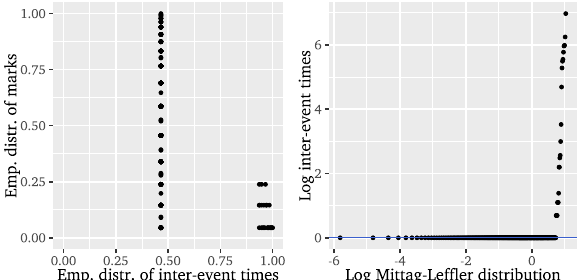
Figure 6. Empirical copula plot for inter–event times and marks, and logarithmic Mittag–Leffler QQ plot of the logarithmic inter-event times.